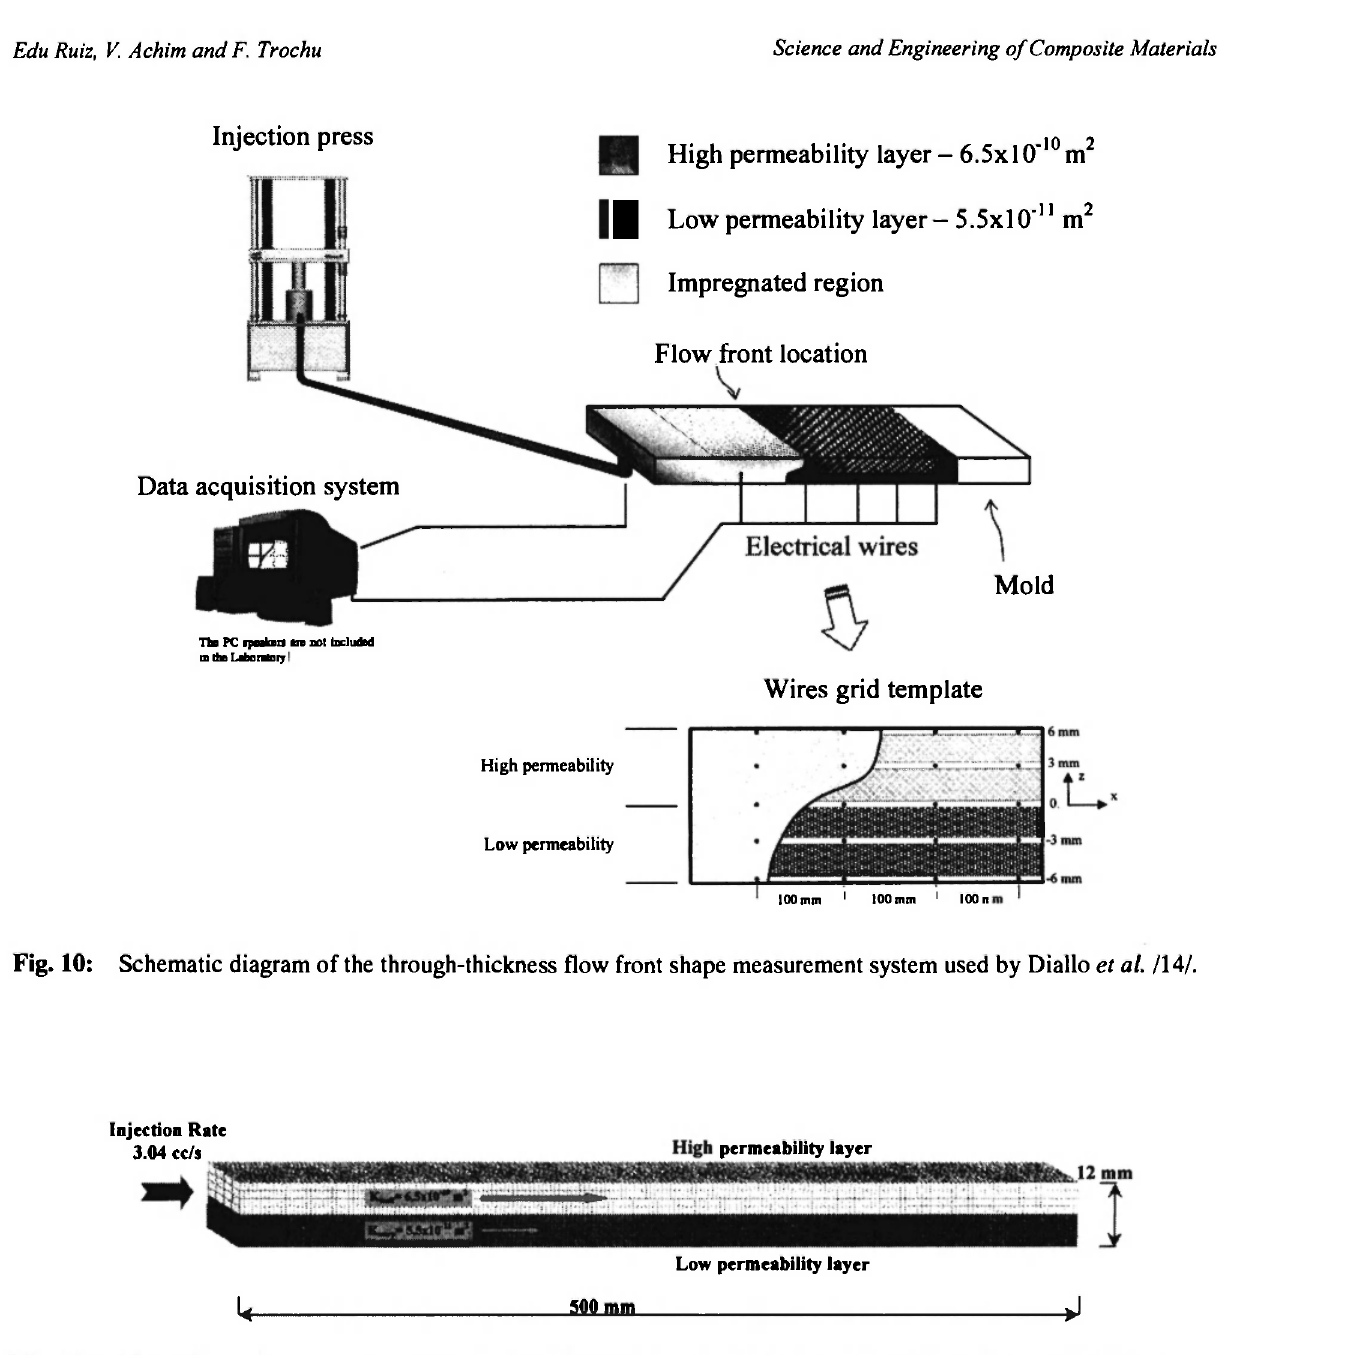
Three-dimensional model used to simulate the experiments of Diallo et al. /14/. In each layer of the laminate the mesh contains 4 prism6 finite elements in the through-thickness direction.